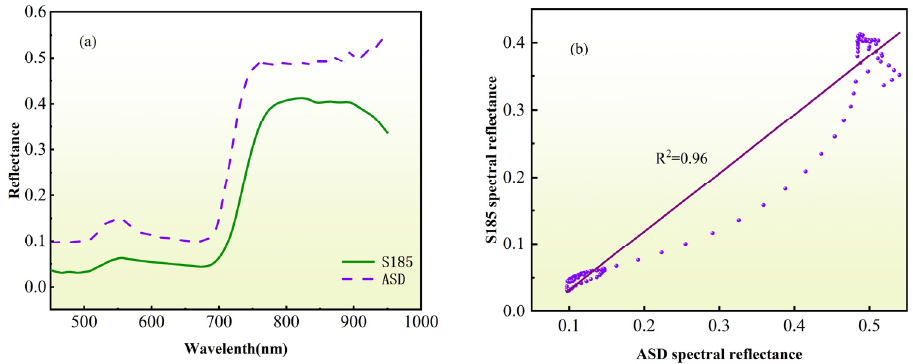
Figure 5. Verification of the reliability of the Cubert S185 hyperspectral image data. ( a ) Comparison of spectral curves between ASD and Cubert S185. ( b ) Correlation analysis of spectral data between ASD and Cubert S185.